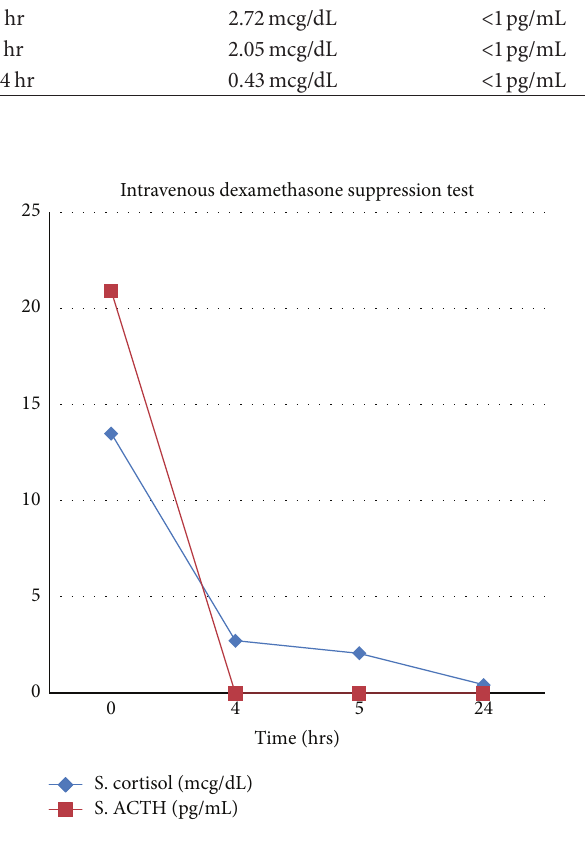
Figure 1: ACTH and cortisol dynamics during the intravenous dexamethasone suppression